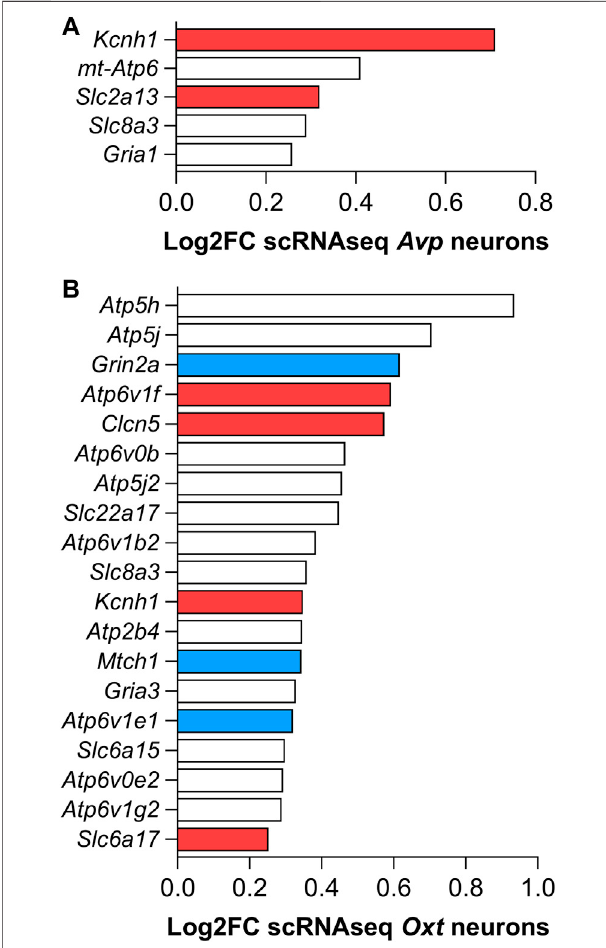
FIGURE3| SetofmRNAscodingchannelsandmembranetransporters positively enriched in (A) AVP- and (B) OXT-producing hypothalamic mouse neurons found with the single-cell RNAseq transcriptome analysis by Romanov et al. (2020). Red colored bars referto thegenesthat, besides being positivelyenriched onAVP- and/orOXT-producingneuronsinmice,are alsoup-regulatedby3 dayswaterdeprivationintheSONofrats.Bluecolored bars refer to down-regulated genes (Pau ž a et al., 2021). White bars refer to genes also regulated in the SON but not discussed in this review.